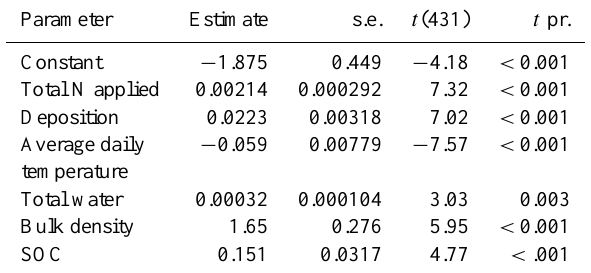
Table 5a. The parameter estimates, standard errors and the proba- bilities for the coefficients included in the multiple regressions for the arable sites.